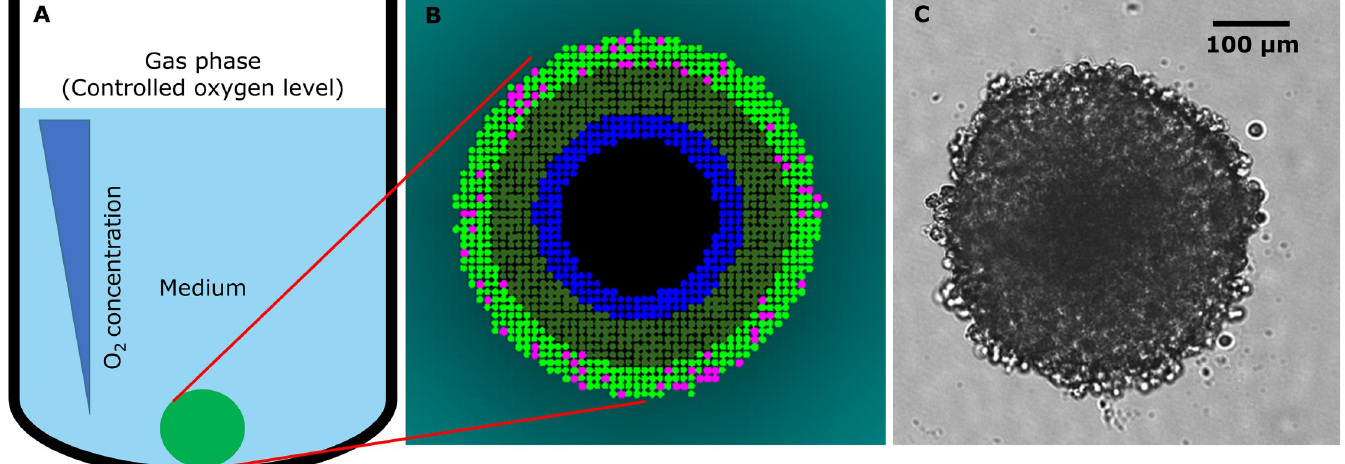
Fig 1. The SABM. ( A) Cells grow as a blob in a specified volume of medium (0.1–0.2 mL). Cells consume O 2 and glucose. O 2 is supplied from the upper boundary and glucose is depleted from the medium unless replenished. Model parameters for diffusion and uptake of constituents, rate of cell growth and death, are acquired from experiments with monolayers and multicellular layers (MCL). Parameters were fitted using the monolayer ABM and Matlab MCL program as described in methods. Time-varying concentration fields of the constituents are solved for in the medium and within the spheroid on a course grid and fine grid respectively (see Figure C), the cells acting as sinks. ( B) Simulation illustrating cell states as a function of local O 2 and glucose concentrations. Once cells double in size they undergo mitosis (pink cells). As the spheroid grows, O 2 and glucose levels decrease in medium near the spheroid (indicated by a cyan color gradient), and decrease in the spheroid core to very low levels with cells becoming hypoxic ( < 0.15 μ M O 2 , dark green cells). Cells starved of O 2 or glucose eventually are tagged to die (blue cells) and then, after a delay, undergo cytolysis, creating a necrotic core (black). ( C) Bright field image of a growing, 4-day HCT116 spheroid seeded at 1000 cells per well.